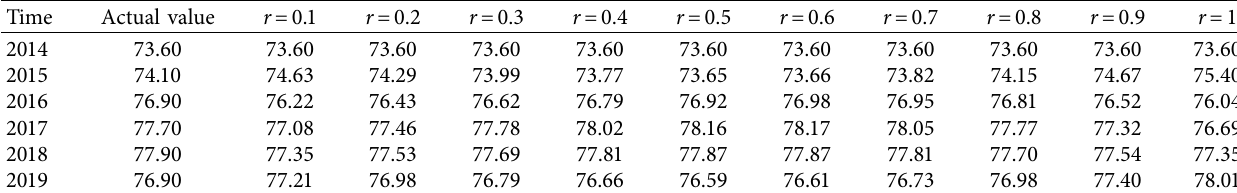
Table 2: Actual values and predicted values (an example of Poland).